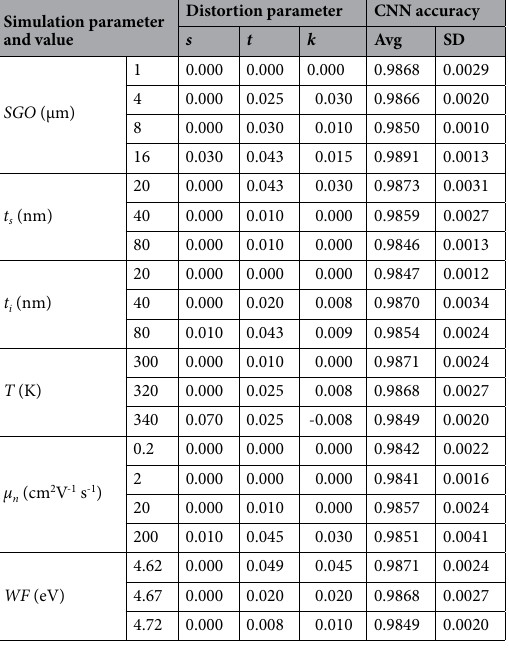
Table 3. Fitting parameter values and network accuracy for simulated devices in which one design parameter varies; a , u and m are always zero (see complete data in Supplementary Table